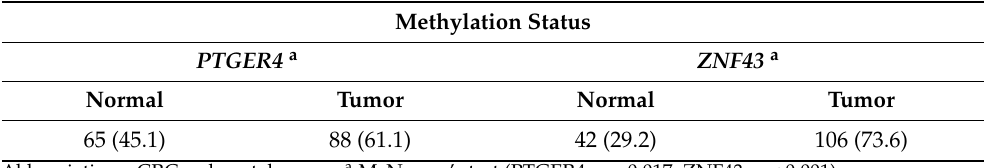
(Table 2). We determined the correlations of the methylation statuses of PTGER4 and ZNF43 with the 5-year RFS, PFS, and OS of the patients. The univariate analysis results for PTGER4 methylation indicated that patients diagnosed with Stage III + IV CRC exhibited unfavorable RFS [HR (95% CI) = 6.32 (3.11–12.86)], which remained significant even after confounding variables were included in the multivariable analysis for normal tissue and tumor tissue [HR (95% CI) = 6.67 (2.31–19.28) for normal tissue; 6.70 (2.31–19.41) for tumor tissue]. With regard to ZNF43 methylation, no correlation was noted between the methylation status of ZNF43 and the likelihood of CRC. However, the Kaplan–Meier survival curves exhibited a different trend, indicating that the methylation of ZNF43 may have influenced the RFS, PFS, and OS of the patients. Table 2. The methylation status distribution of candidate genes in tumor tissue and adjacent normal tissue from CRC patients. Methylation Status PTGER4 a ZNF43 a Normal Tumor Normal Tumor 65 (45.1) 88 (61.1) 42 (29.2) 106 (73.6)